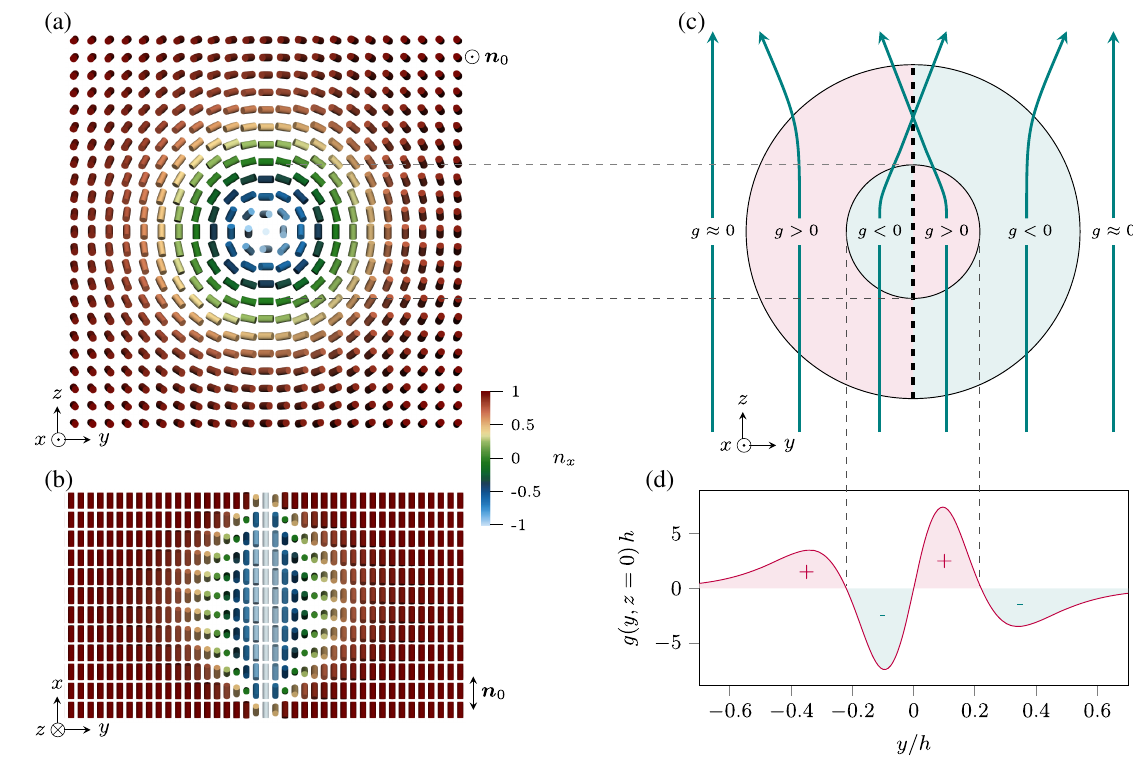
FIG. 7. Top (a) and side (b) view of the director field of a baby skyrmion. We use the same axis convention as in Fig. 3. The color scale is the same for (a) and (b). (c) General trajectories of extraordinary rays deflected by the baby skyrmion, as predicted by the simple ray- tracing model of the main text. (d) Variations of the quantity g introduced in the main text along a line parallel to y and centered on the baby skyrmion. h is the sample thickness. The sign of g allows us to predict the sign of deflection of the